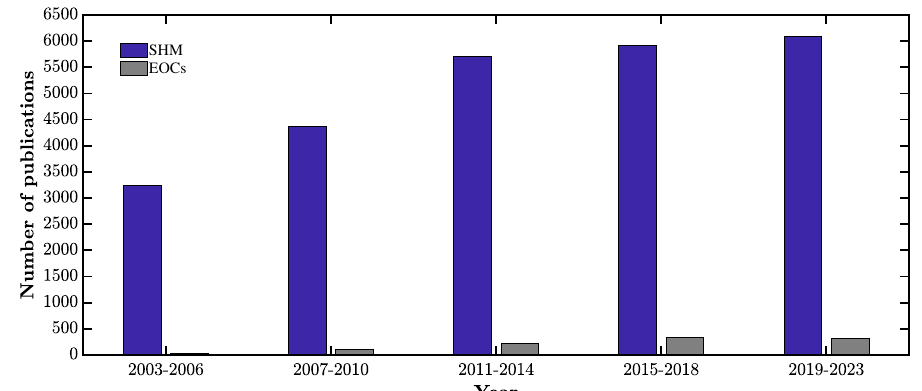
Figure 2. Number of publications with SHM or EOCs in their title.